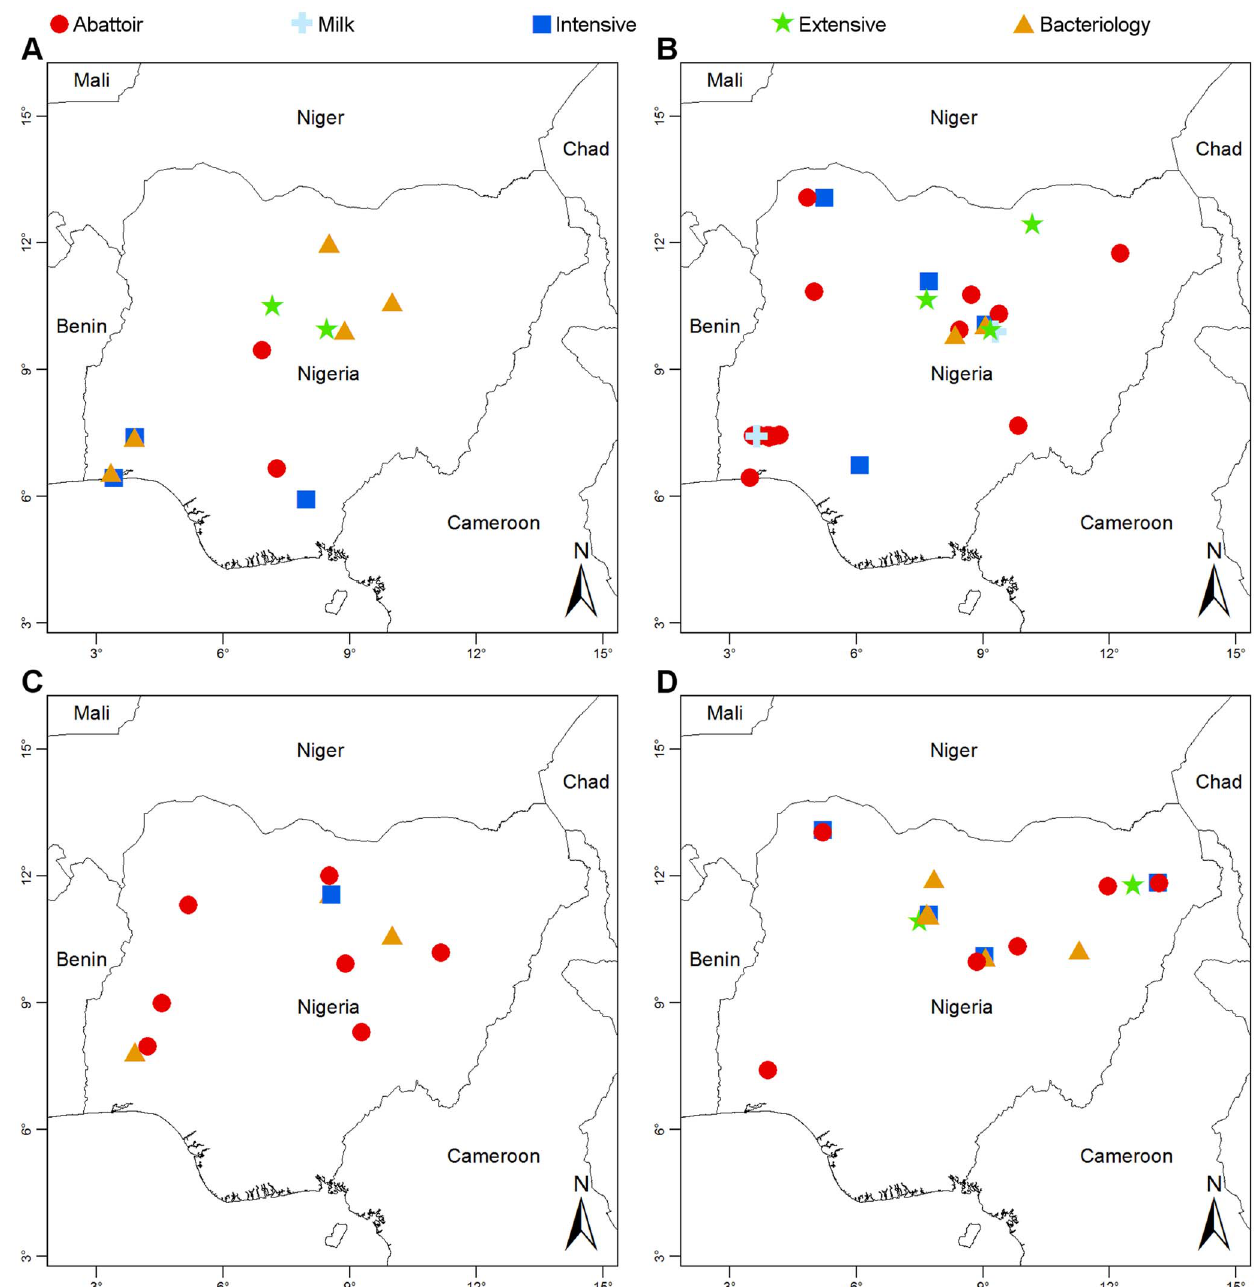
Figure 3. Location of brucellosis studies in Nigeria. (A) cattle; (B) sheep and goats; (C) camels and pigs; and (D) humans.